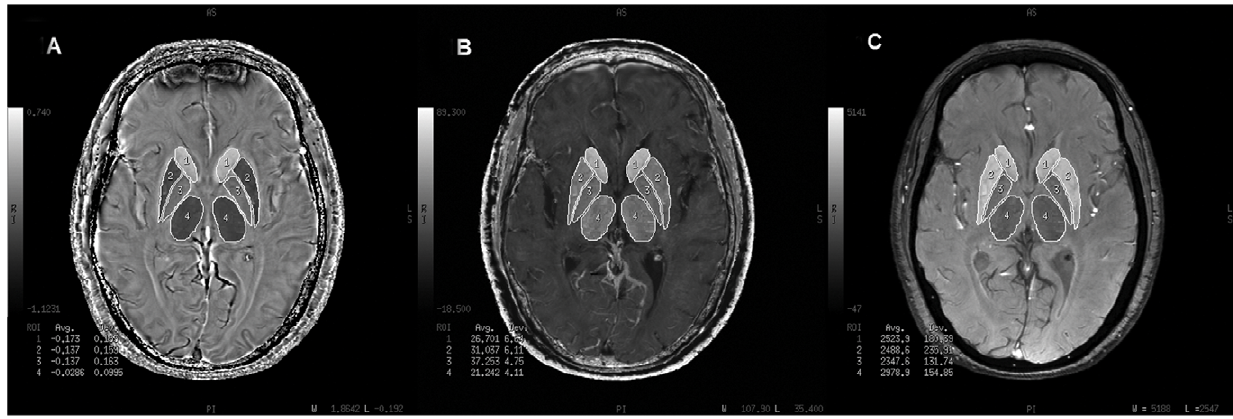
Figure 1. Illustration of the selected regions of interest. (A), The selected ROIs of the corrected phase images. (B), The selected ROIs of the R2* images. (C), The selected ROIs of the magnitude images. 1=caudate; 2=putamen; 3=globus pallidus; 4=thalamus.